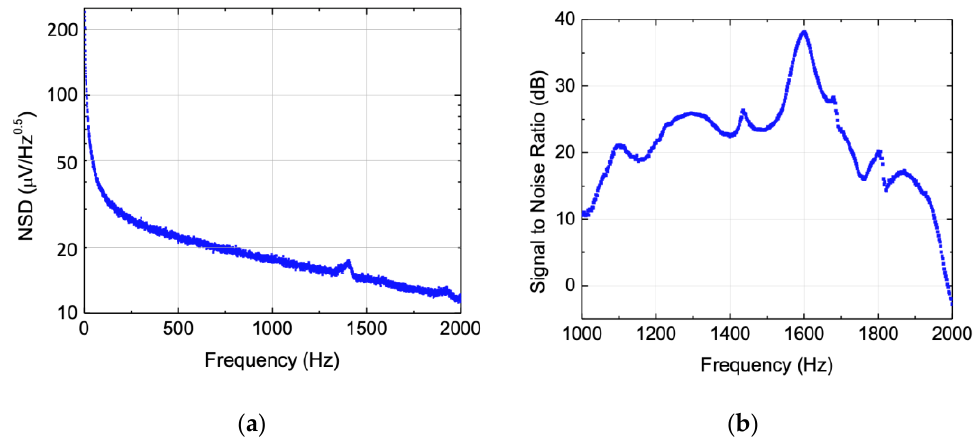
Figure 8. ( a ) Noise spectral density of the MEMS sensor measured underwater. ( b ) Estimated signal-to-noise ratio over 1 kHz band for an acoustic stimulus of 1 Pa (details in the text).